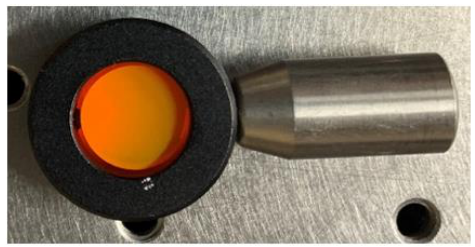
Figure 2. A synthesized solid-state dye. A diode laser of 1 W output at 530 nm was used as a pumping light source to excite the solid dye. In order to analyze the photodissociation of the solid dye, the pulse width of the pumping laser was adjusted to 2.5, 5, and 10 ms with pulse width modulation. The pulse repetition rate of the diode laser was fixed to 10 Hz. Evaluating the optical properties of the solid dye, we used a static modulated Fourier transform spectrometer based on a modified Sagnac interferometer. In order to transmit the fluorescence from the solid dye to the interferometer, a flat-convex lens with focal length and diameter of 100 mm and 2 inches was used. Two mirrors in the interferometer are square and 2 inches wide. The surfaces of the mirrors were coated with silver. The beamsplitter was coated to have a transmittance of 50% from 488 to 694 nm. The beamsplitter was tilted 45 ◦ from the optical axis, and the two mirrors were each tilted 22.5 ◦ from the optical axis. The displacement of M2 was 1 mm. To collect the light passing through the interferometer to the detector, a planar lens with a focal length of 100 mm and a diameter of 2 inches was used. The measurement wavelength range of the one-dimensional array detector was 200 to 1100 nm, and the effective number of pixels was 2048. The width of a single pixel in the detector was 14 µ m. By combining a thermal imaging camera with 320 and 240 pixels in the horizontal and vertical directions with a spectrometer, the temperature change in the solid dye along with the change in the spectral signal were obtained simultaneously. Figure 3 shows the spectrometer in this study.